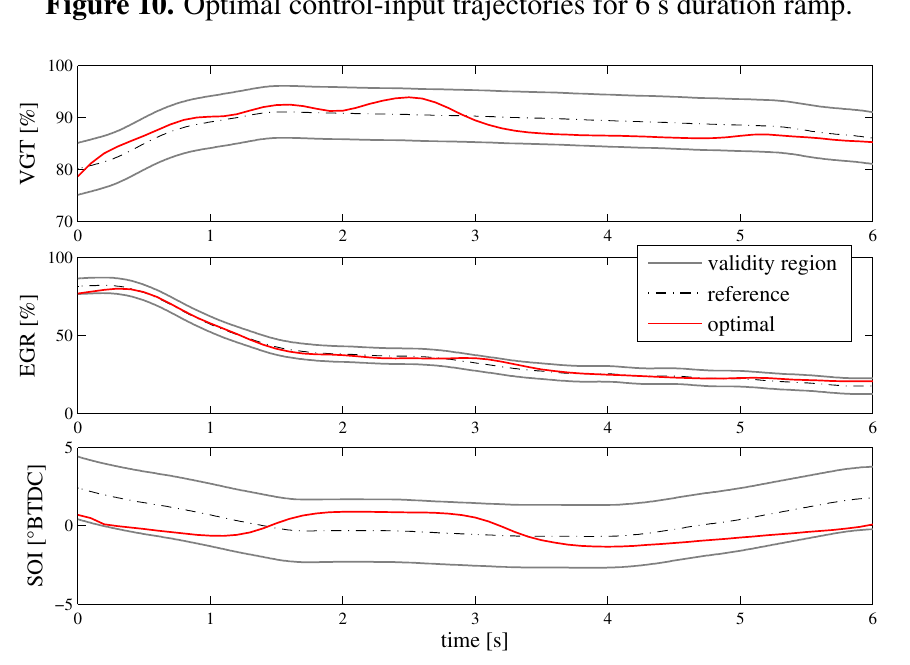
Figure 10. Optimal control-input trajectories for 6 s duration ramp.